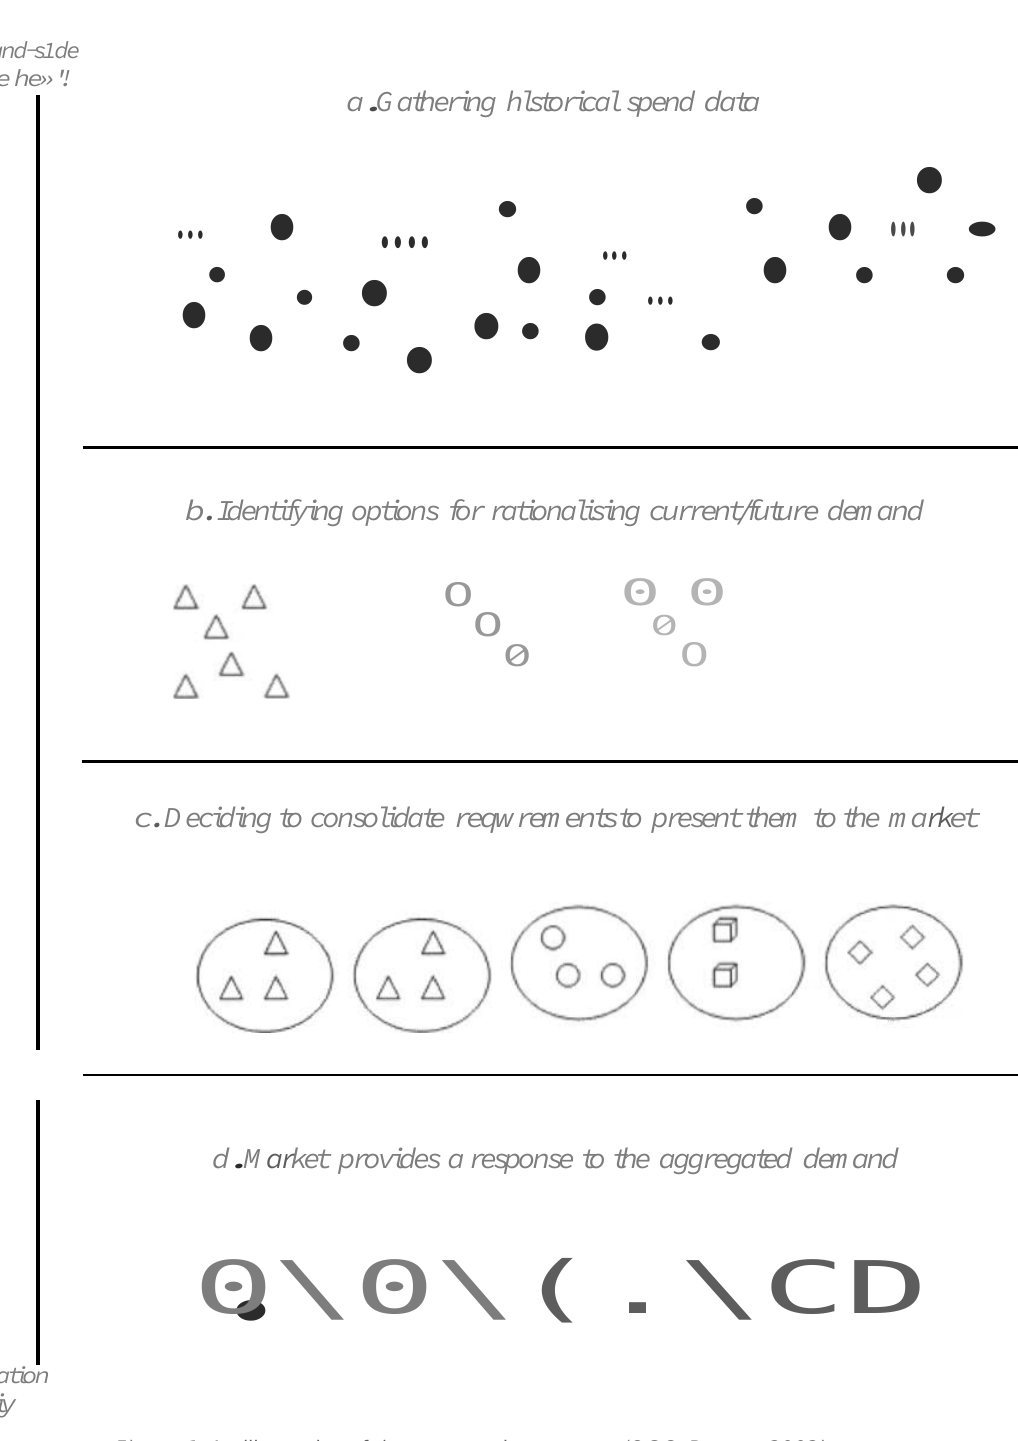
Figure 1: An illustration of the aggregation process (OGC Report,